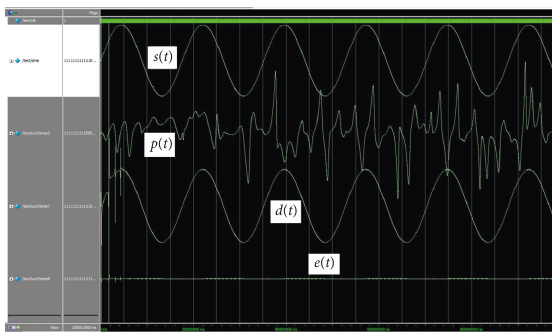
Figure 19: Experimental results of chaotic masking secure com- munication based on